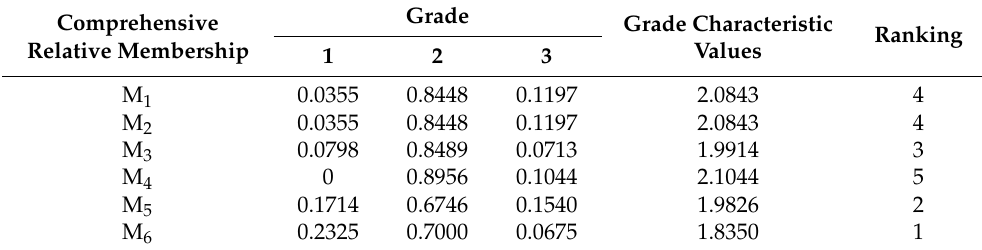
Table 4. Optimal decision